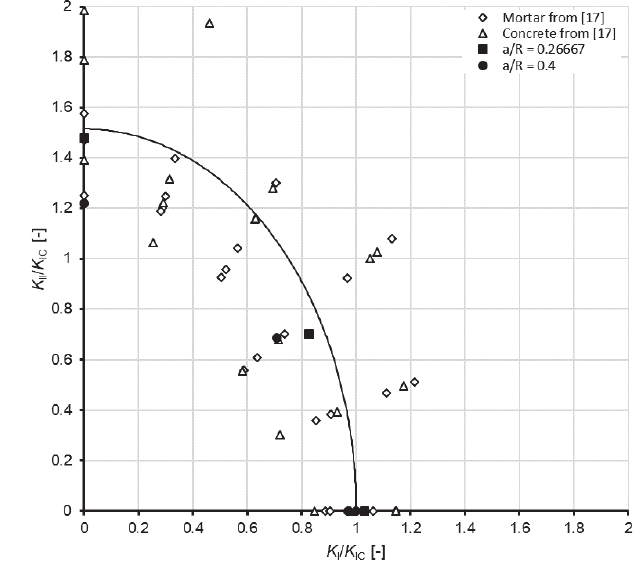
Figure 6: Comparison of fracture resistance K II / K IC ( y axis) against K I / K IC ( x axis) behavior with data from literature